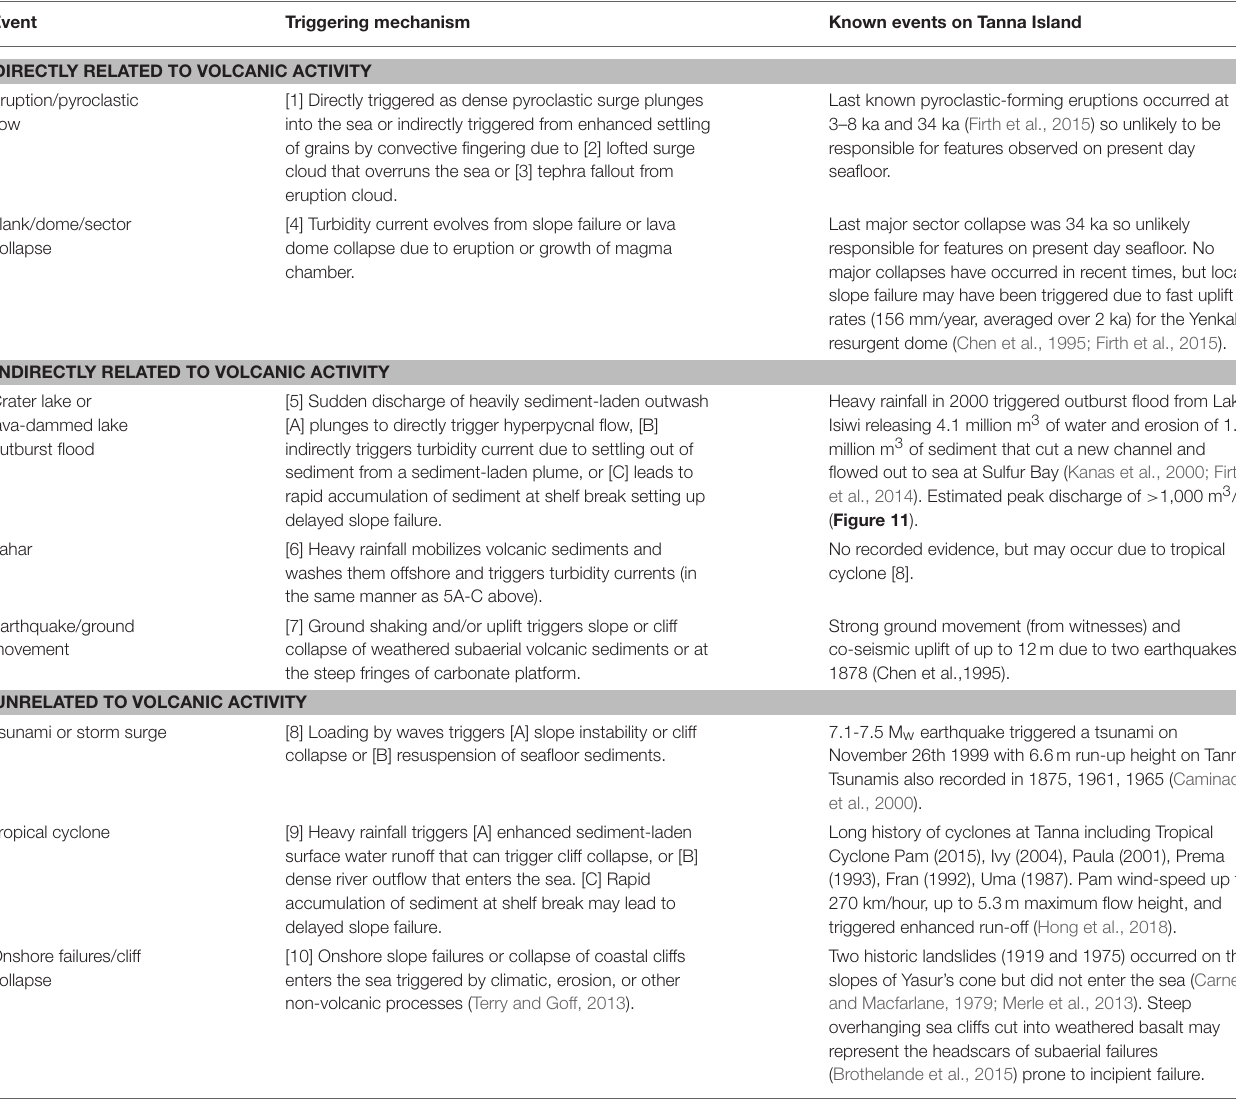
TABLE 1 | Review of possible triggers for turbidity currents and submarine landslides at volcanic islands, with specific reference to documented events at Tanna Island (parenthesized numbers are cross-references to Figure 11